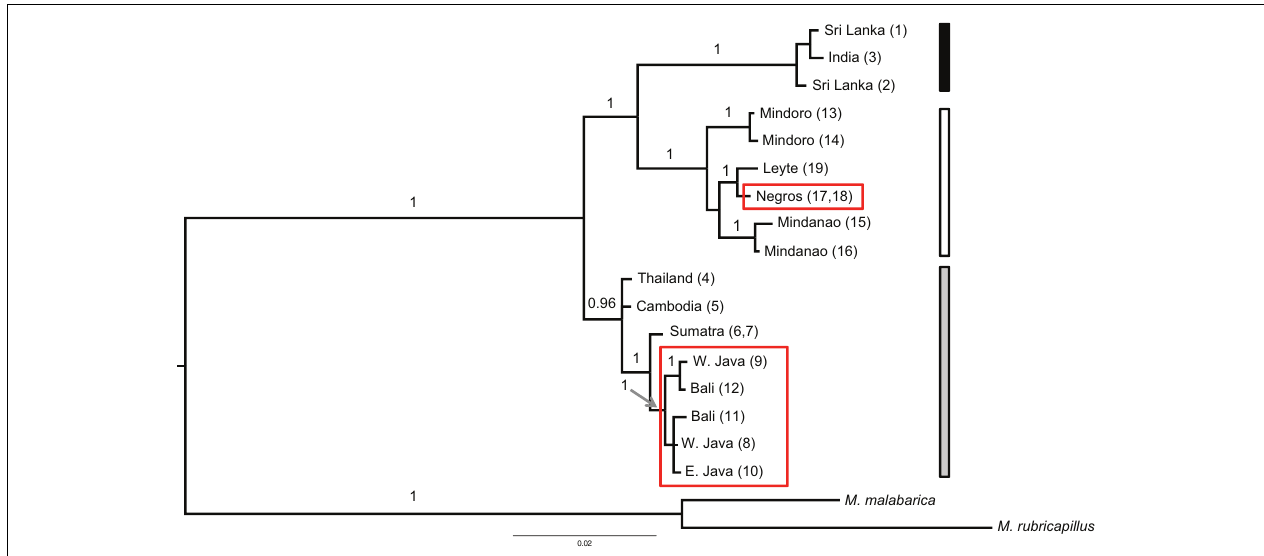
FIGURE 3 | Bayesian tree of the combined data set ( cyt b and ND2 ) based on a six partitioned model (each marker with a three codon position model) excluding identical haplotypes ( n = 2) and two samples with too much missing data (the Cebu and Singapore samples). The Bayesian posterior probability (when ≥ 0.95) is indicated above the branch.